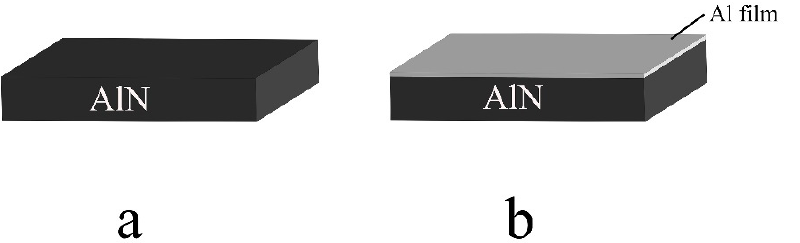
film deposited. Figure 2. Two groups of AlN ceramic samples ( a ) without Al film deposited; ( b ) with Al film de- posited.